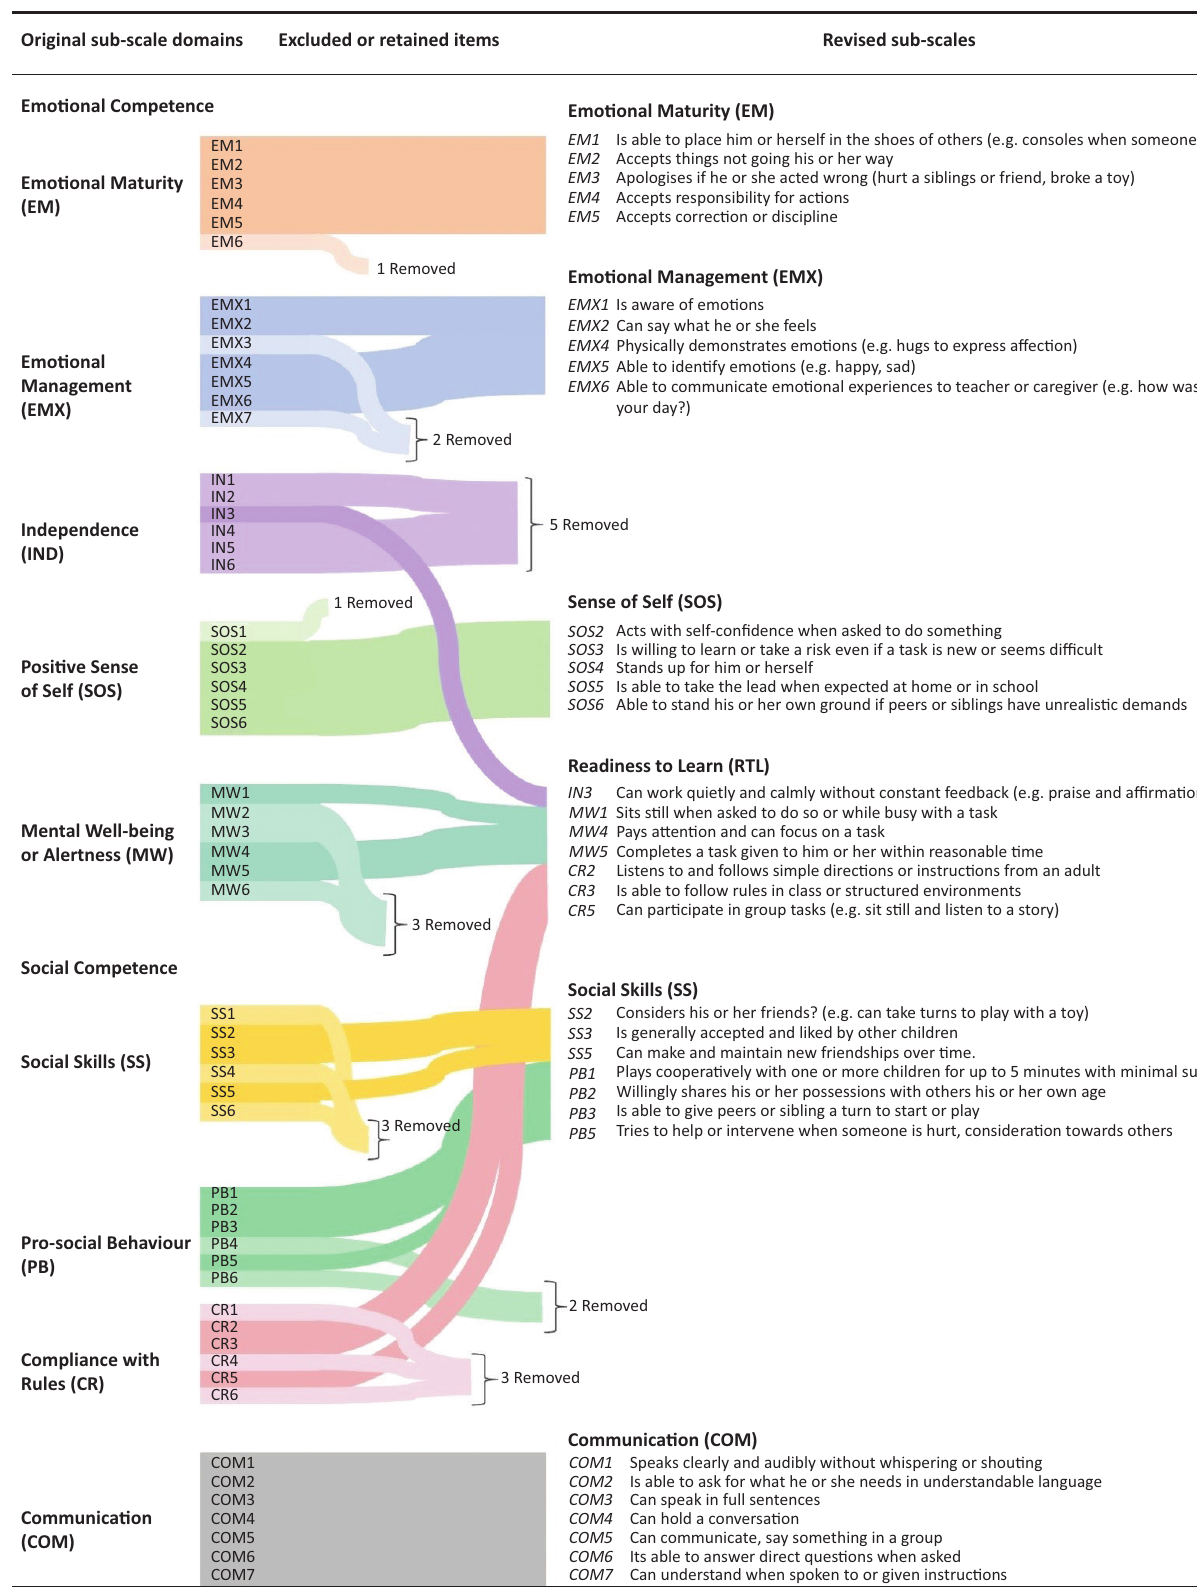
FIGURE 1: Original and revised emotional social screening tool for school readiness Secondly, three separate domains in the theoretical model were merged into one. The proposed merger between Independence, Mental Well-being and Alertness, and